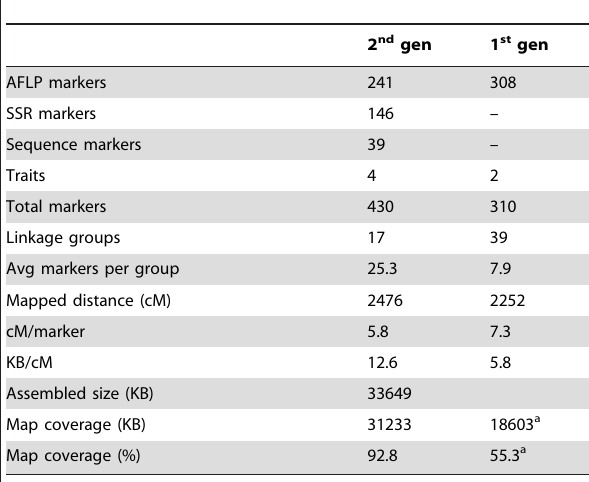
Table 1. Compared mapping data between 1 st and 2 nd Heterobasidion annosum s.l. linkage